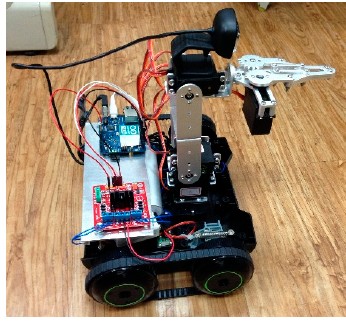
Figure 3. The mobile robot.